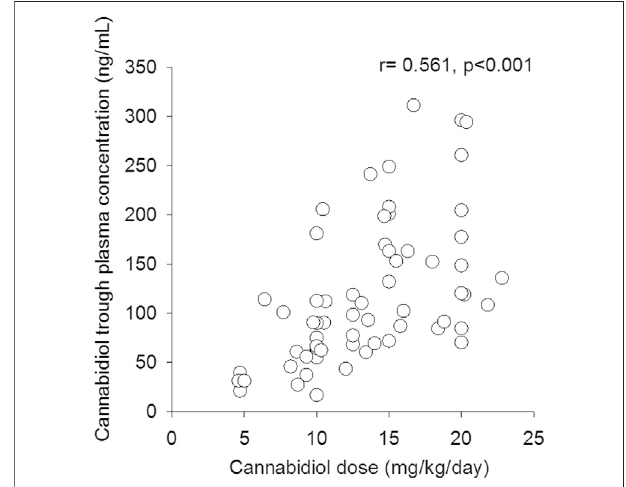
FIGURE 1 | Correlation between cannabidiol trough plasma concentrations and related weight-adjusted daily doses (n (cid:1) 67).